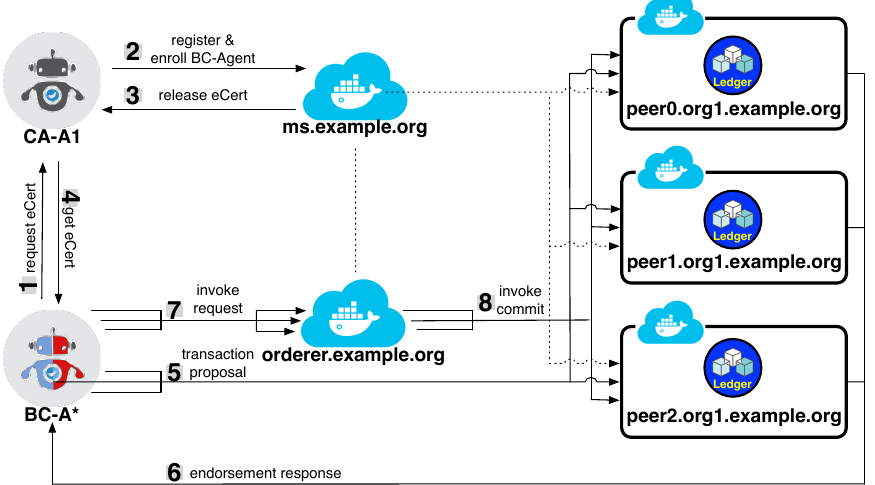
Figure 2. Design and interactions among the system components [10].